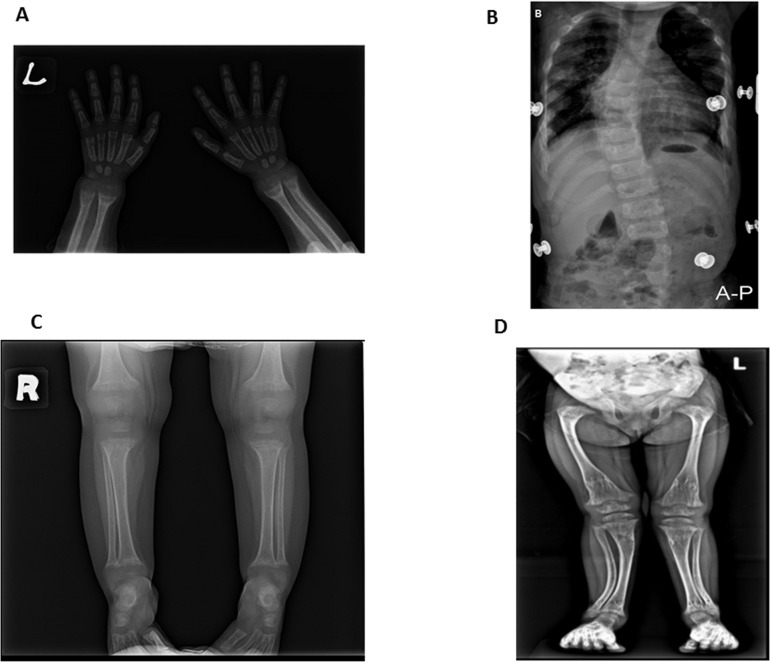
(A) Antero-posterior radiograph of the patient’s hand with rickets demonstrates cupping and fraying of the metaphyseal region. (B) Antero-posterior radiograph of the patient’s chest showing scoliosis of the thoracolumbar spine with Cobb’s angle of 31degrees. (C) Antero-posterior radiograph of lower extremities revealed widening between the distance of the end shaft and epiphyses. (D) The curvatures of legs revealed genu valgum with intermalleolar distance (IMD) of 5.0cm.